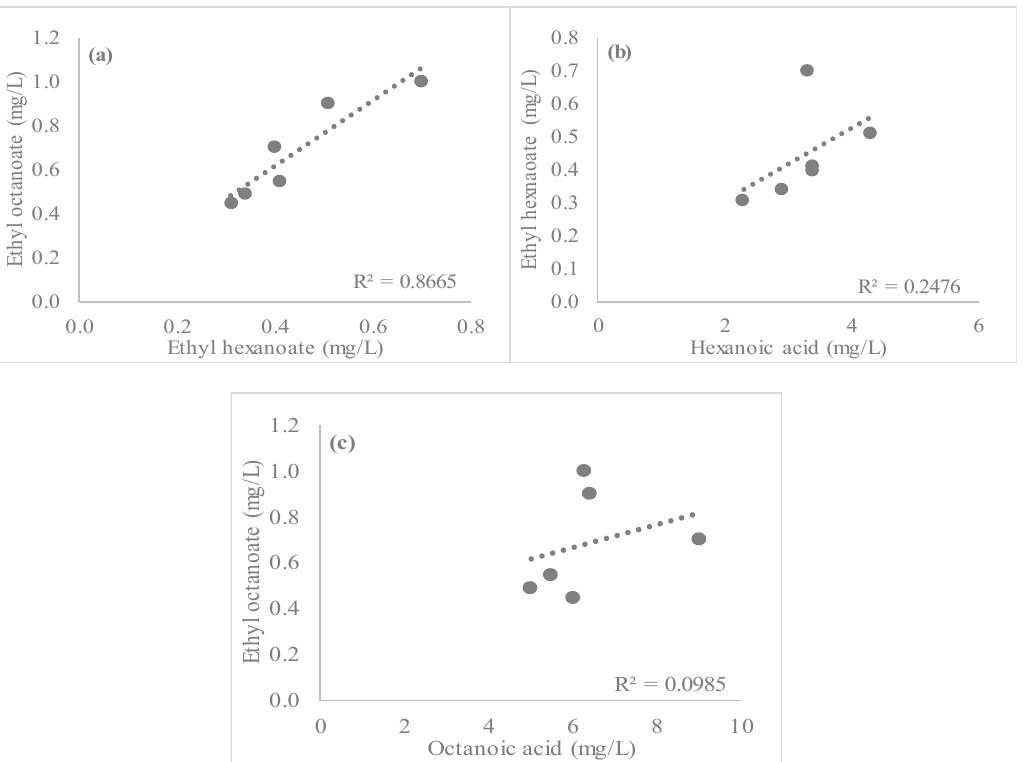
Figure 5. Correlations between the concentrations (mg/L) ( a ) ethyl octanoate and ethyl hexanoate, ( b ) ethyl hexanoate and hexanoic acid, and ( c ) ethyl octanoate and octanoic acid (in six fresh beers: A–F).